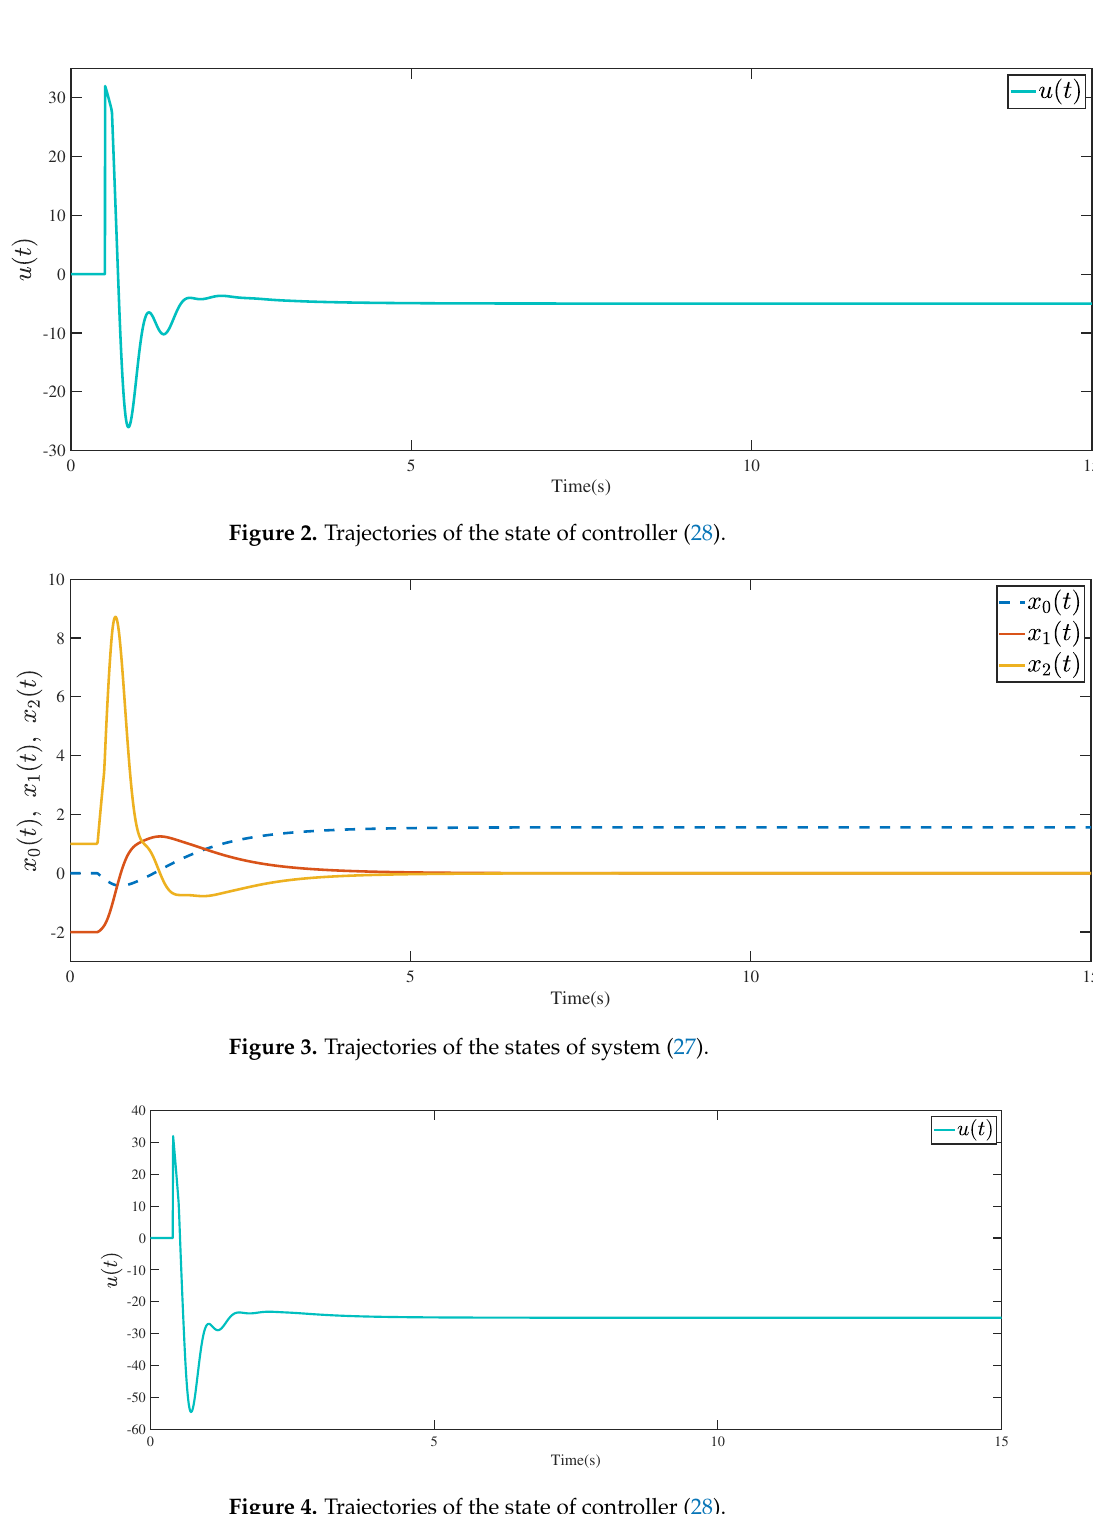
Figure 4. Trajectories of the state of controller